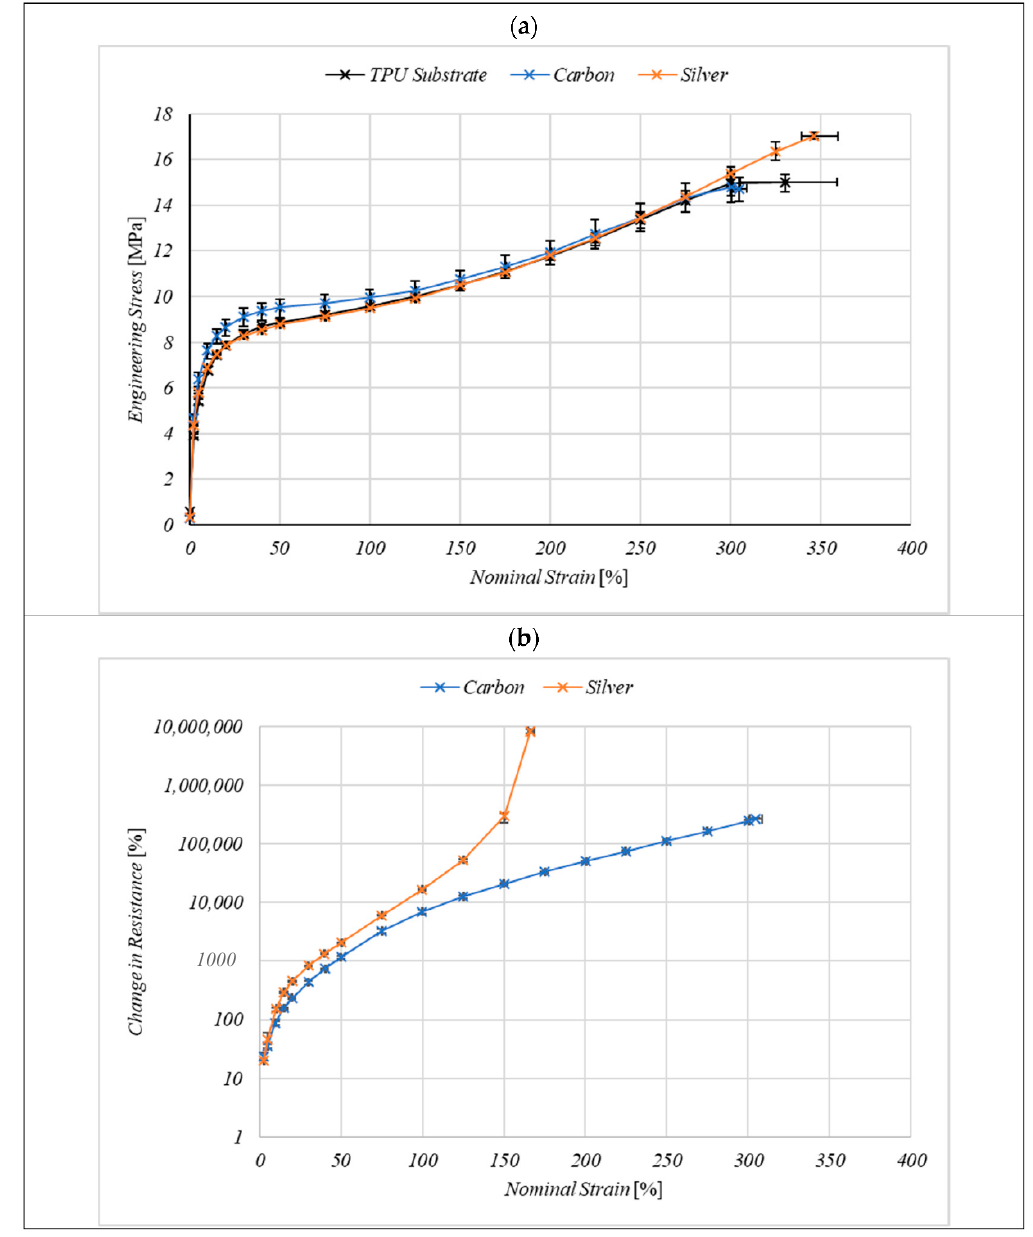
Figure 5. ( a ) The effect of carbon and silver ink coatings on the stress–strain curve of the TPU substrate during a maximum extension test at 50 mm/min. ( b ) the effect of nominal strain on the electrical resistance of the coatings. Data represent the mean of n = 3 samples where error bars represent the range.